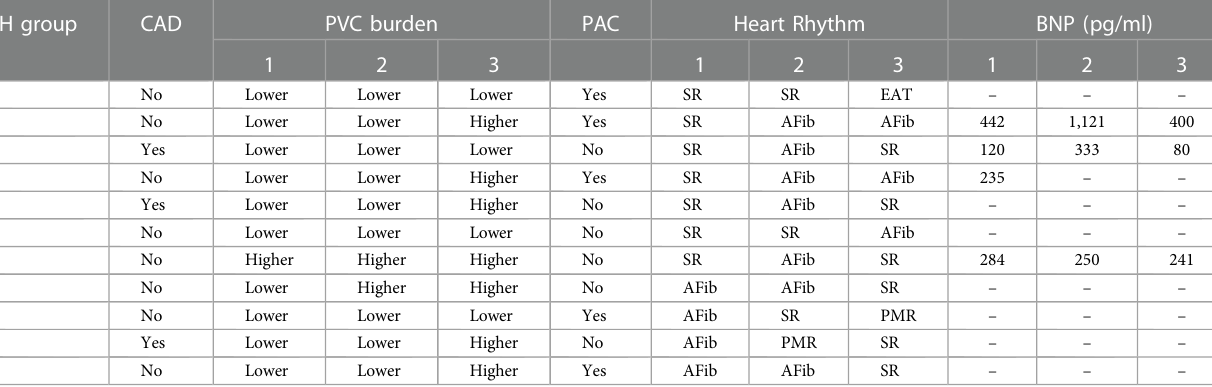
TABLE 5 Patients with changing heart rhythm during Holter electrocardiogram